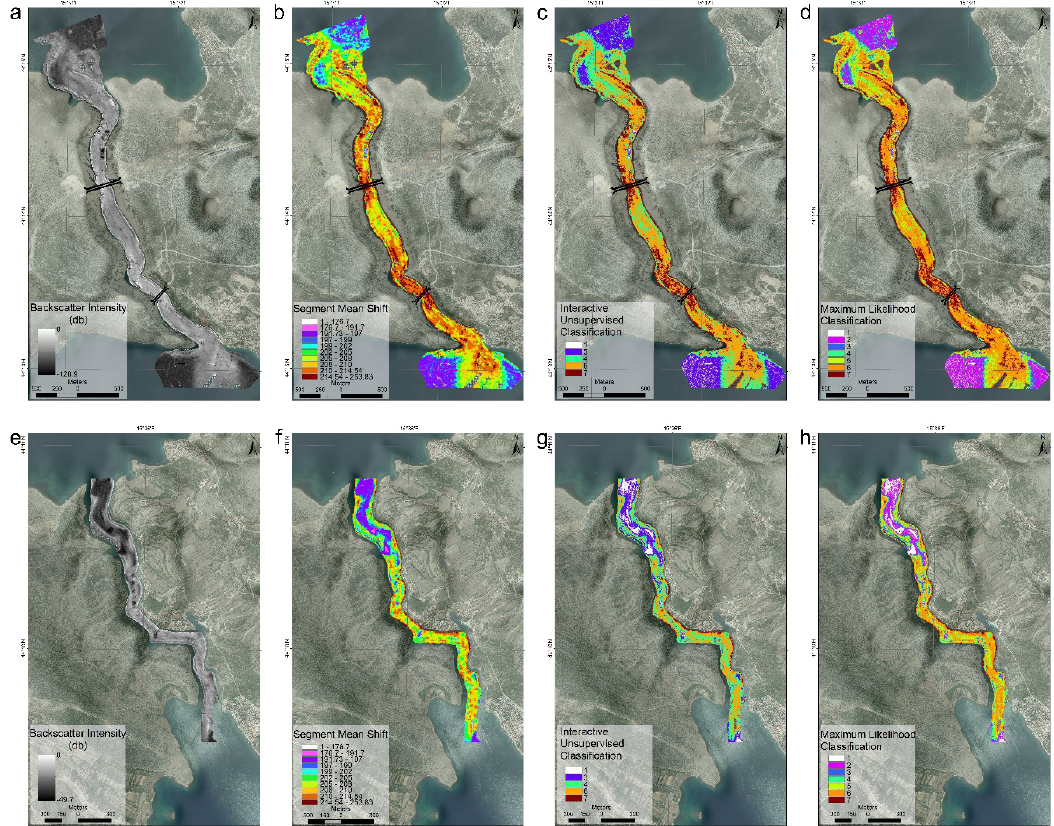
Figure 5. ( a ) Backscatter data of the NZD channel. ( b ) Segment mean shift classification of the NZD area. ( c ) Interactive unsupervised classification (uISO) of the NZD area. ( d ) Maximum likelihood classification of the NZD area; the two bridges across NZD are illustrated as references. ( e ) Backscatter data of the KZD channel. ( f ) Segment mean shift classification of KZD. ( g ) uISO classification of KZD. ( h ) Maximum likelihood classification of KZD.